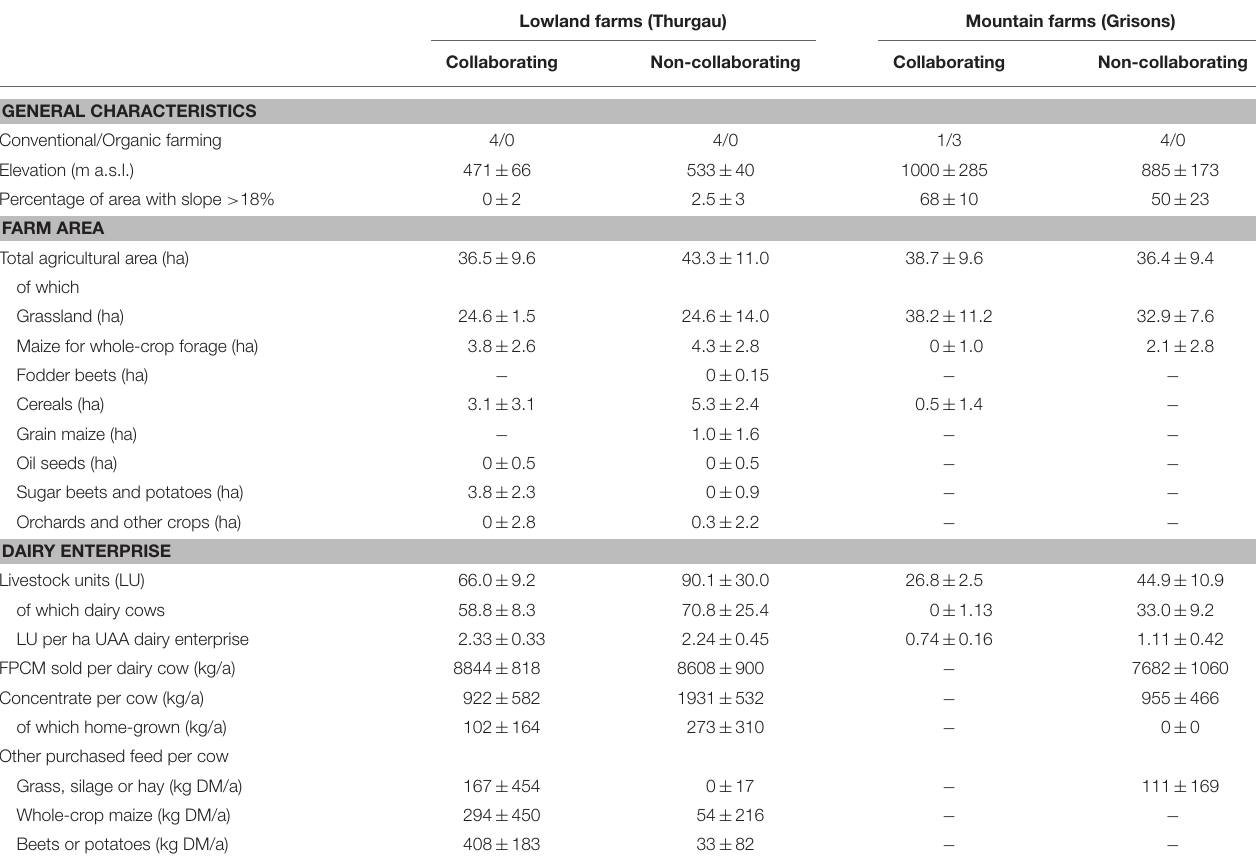
TABLE 1 | Farm characteristics; median and mean deviation of the median per farm